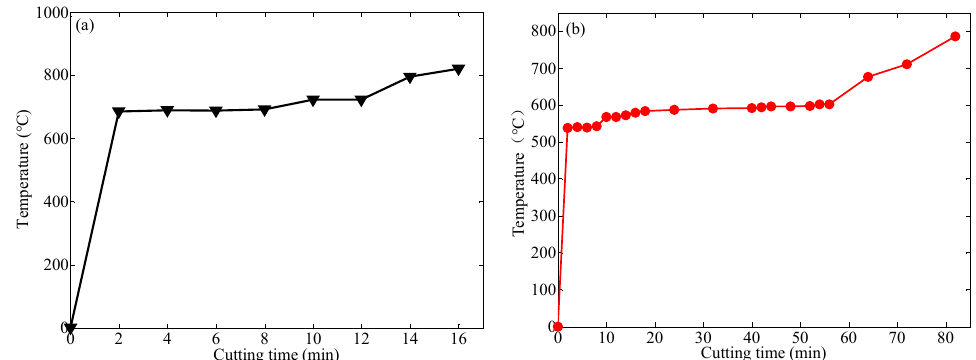
Figure 9. ( a ) Temperature change around the tool A tip. ( b ) Temperature change around the Tool B tip.